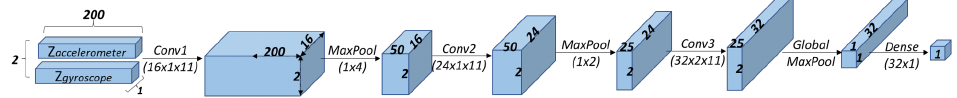
Figure 8. Overall architecture of developed Deep CNN for activity recognition task. Input tensor has two rows representing produced Z ( i ) for accelerometer and gyroscope, each one of them containing 200 values and one channel. Every convolutional operation is followed by a ReLU activation function, and pooling layers are followed by a dropout equal to 0.5. Final dense layer outputs one value and is followed by a sigmoid operation that represents probability of SaR dog searching or